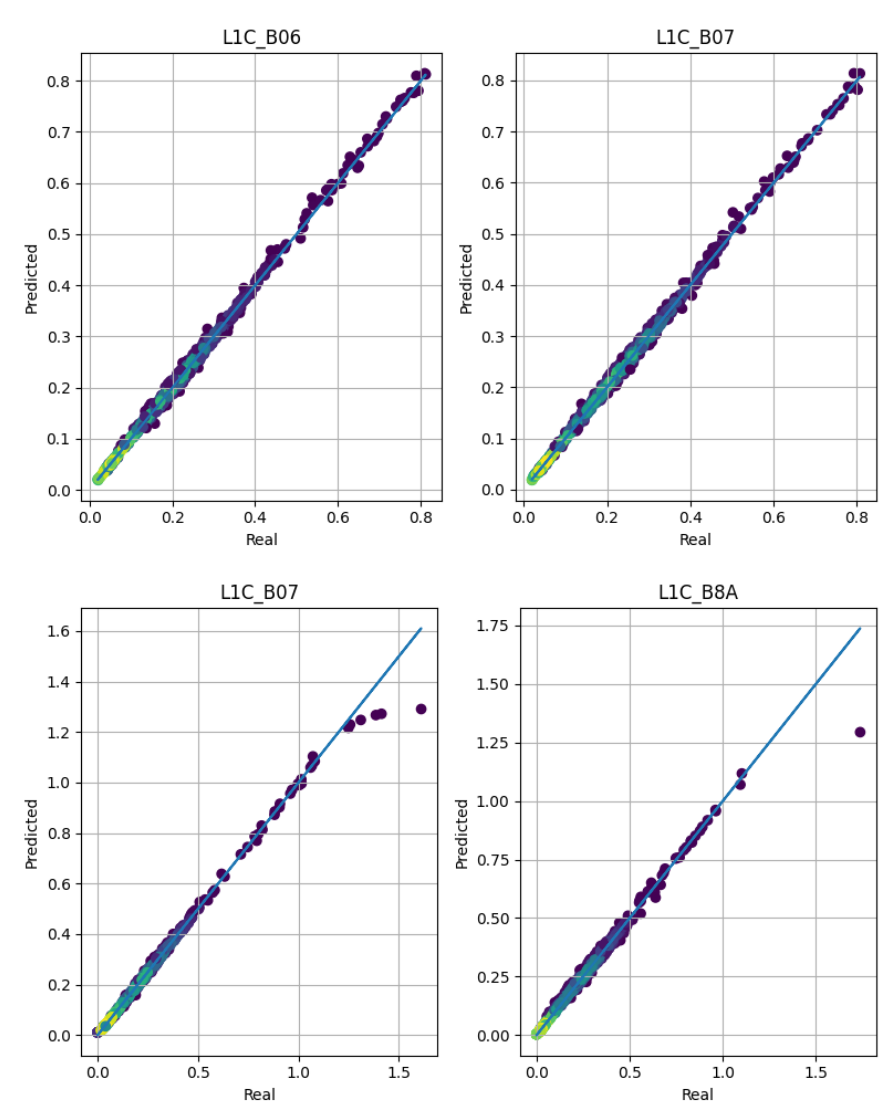
Figure 11. Scatterplots for the double-band regression (L1C). Each row in the figure corresponds to a row in Table 15. The colors Figure 7. Scatterplots for the single band regression (L1C). The colors indicate the density of